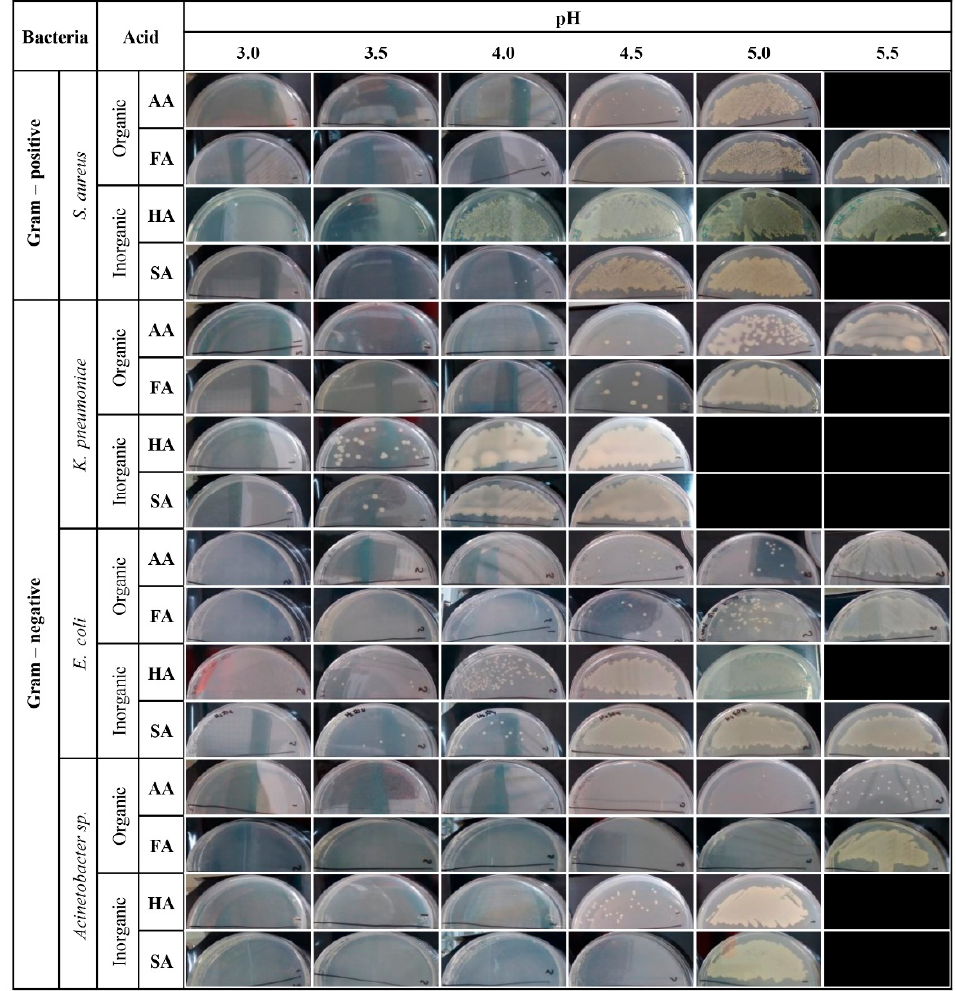
Figure 2. Effect of different acidic environments on bacterial viability, evaluated by subculturing in neutral pH MHA medium after growth in pH adjusted MHB medium. For simplification, only a representative plate for each combination of bacteria/condition out of the triplicate assays performed on two different days is presented. Legend: AA–acetic acid, FA–formic acid, HA–hydrochloric acid, SA–sulphuric acid.